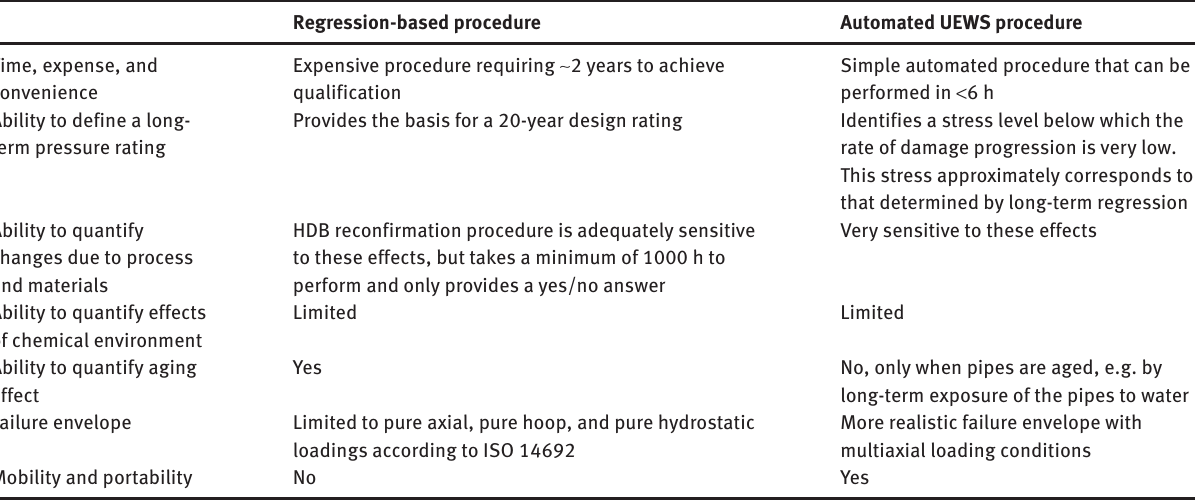
Table 2: Comparison of regression-based and ultimate elastic wall stress (UEWS) test procedure. Regression-based